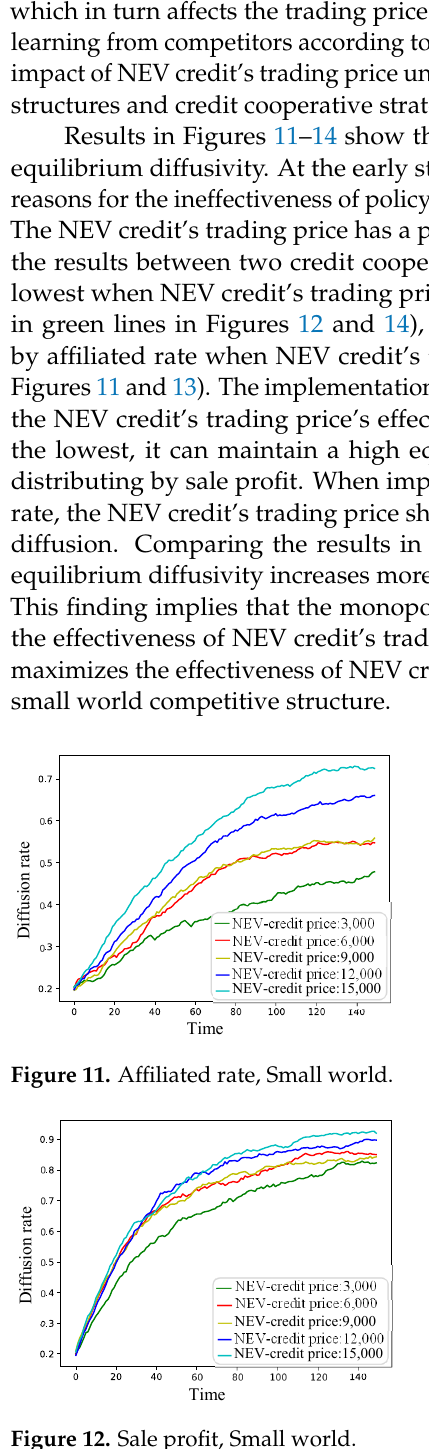
Figure 13. Affiliated rate, Scale free. Figure 14. Sale profit, Scale free.